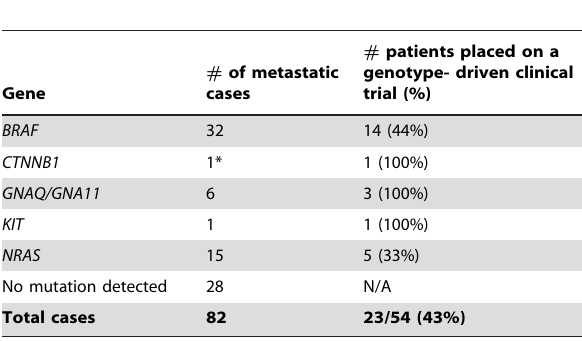
Table 4. Influence of tumor genotype on subsequent treatment in patients with metastatic